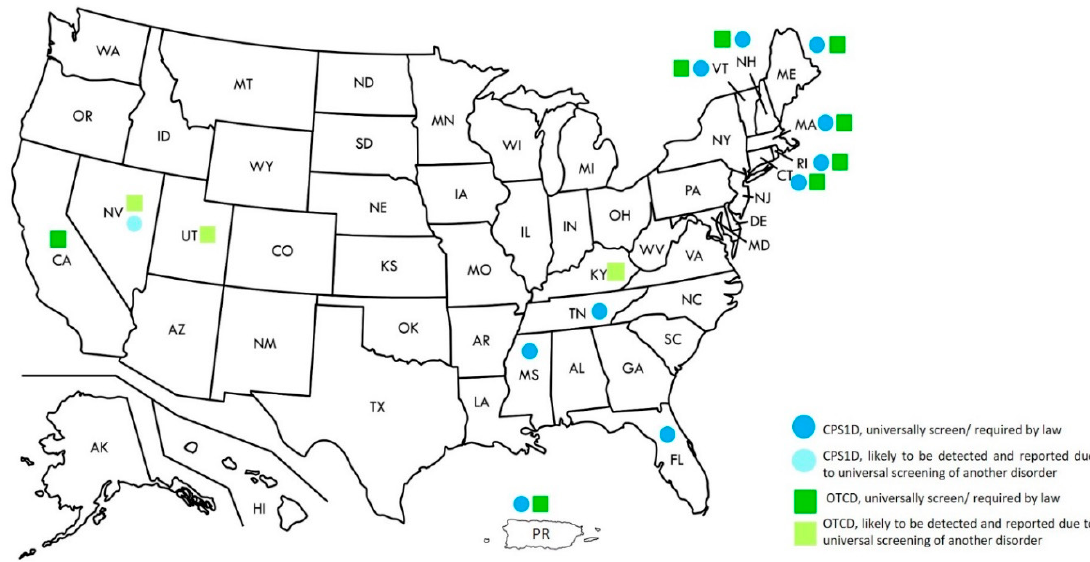
Figure 1. Newborn screening for Urea Cycle Disorders in the United States, 2020.